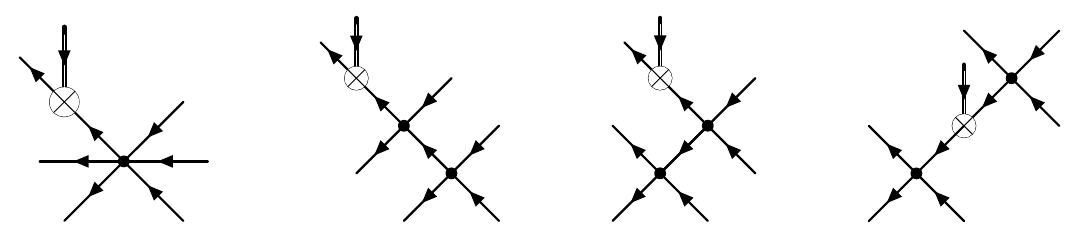
Figure 6 . Diagrams for three-particle, length-one form